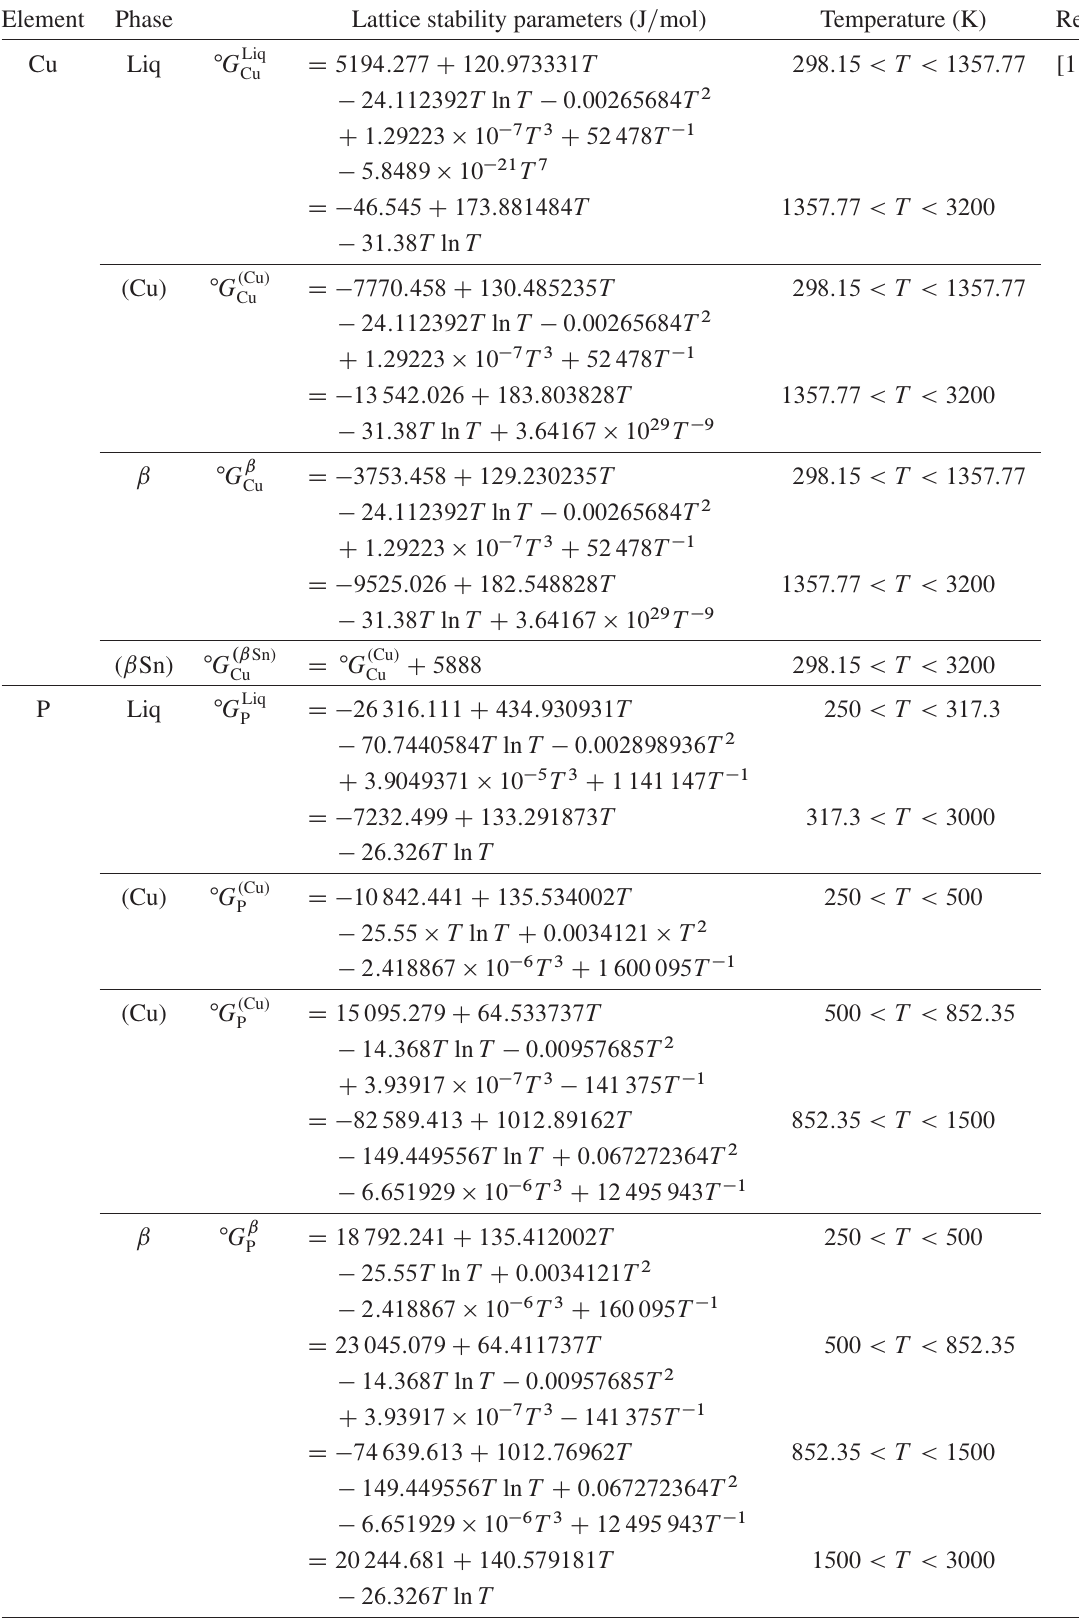
Table 1. Lattice stability parameters for Cu, P, and